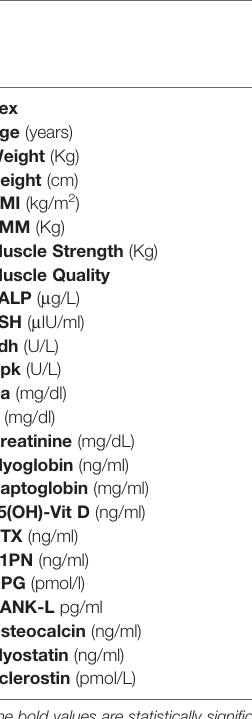
TABLE 2 | Linear Correlation between Irisin and all other parameters ( Spearman Rank Order